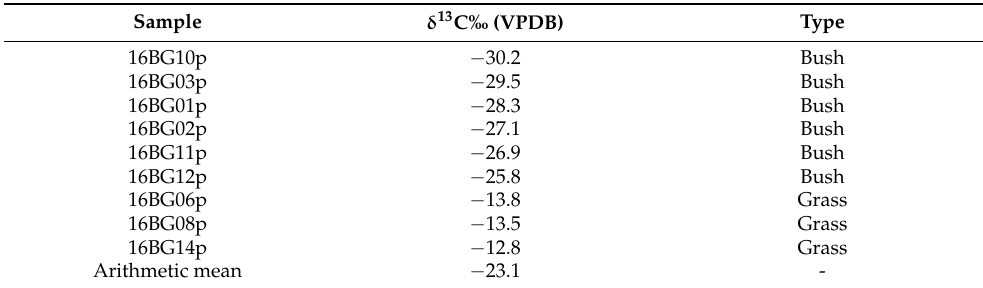
Table 3. δ 13 C o values for modern plants samples in the Bagua Basin.